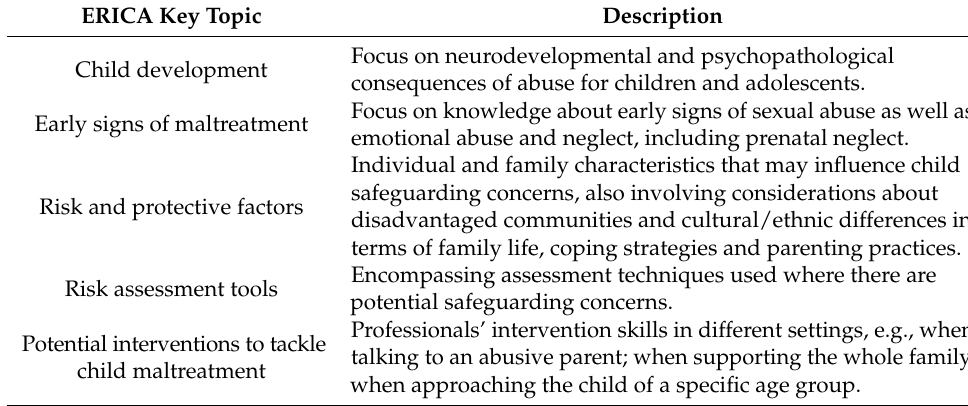
Table 1. Child protection-related key topics of the ERICA digital training interactive modules. ERICA Key